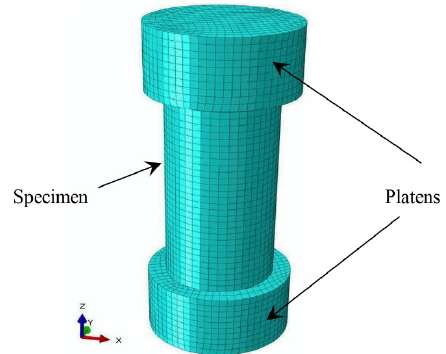
Figure 2. The finite element model of the Ni-based BMG rod with a diameter of 1mm.